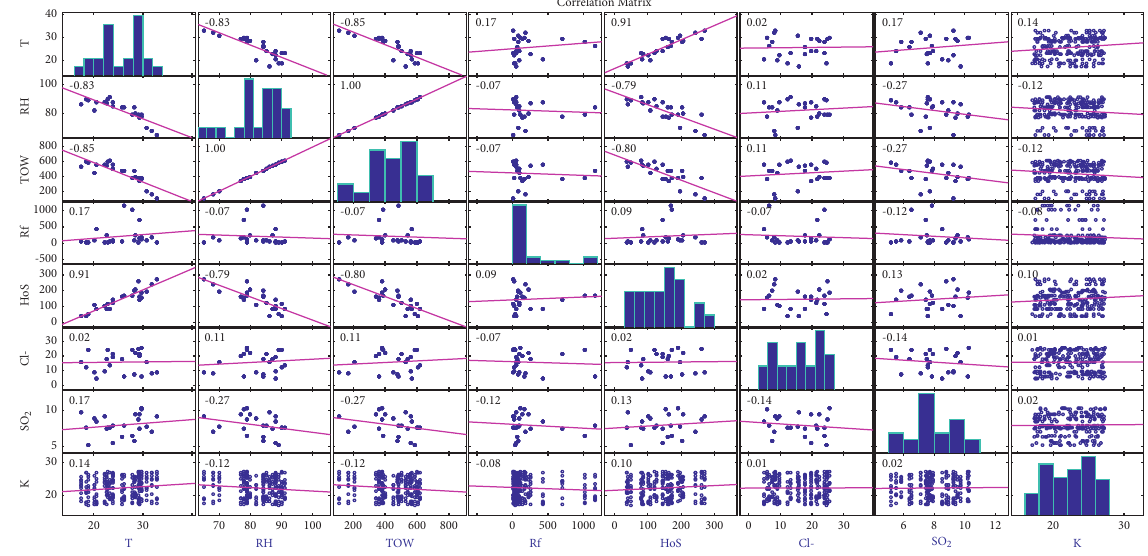
Figure 2: Correlation between input parameters in the dataset. Table 2: Formulas for calculating the atmospheric corrosion rate of carbonic steel.